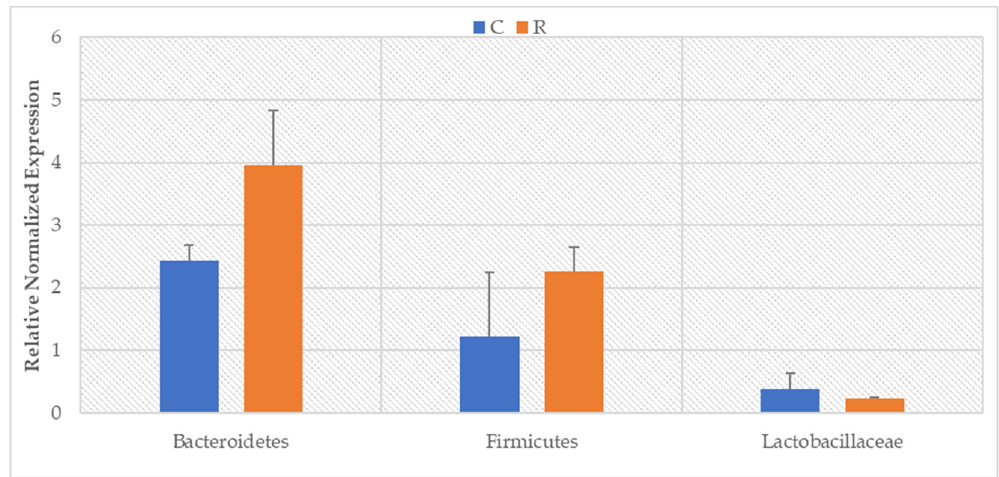
Figure 1. The level of bacteria (RNE) in the feces of animals before exercise (C) and after race (R).